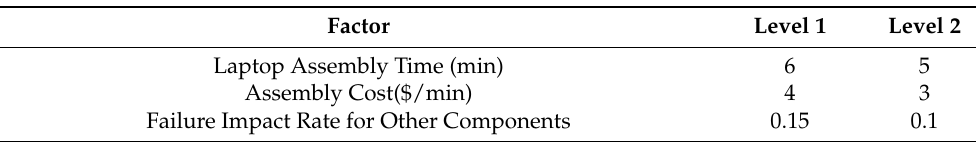
Table 9. Remanufacturing assembly and failure impact rate